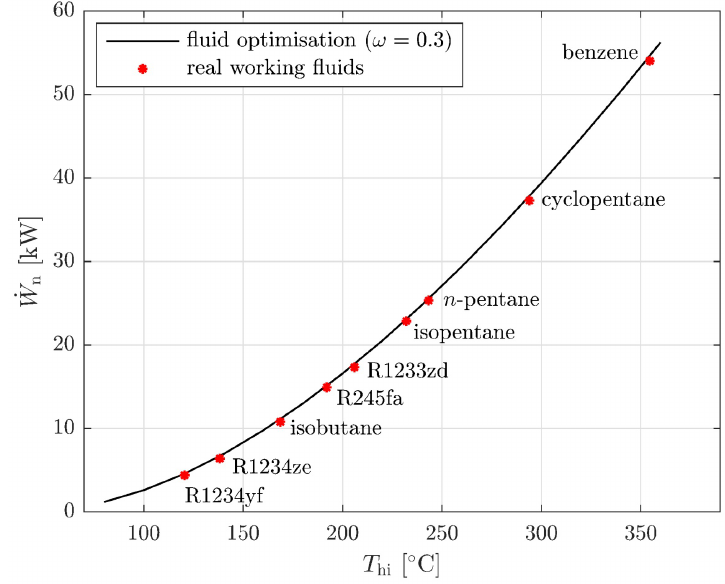
Figure 7. Working fluids comparison cycle optimizations with different working fluids operating in sub-critical ORC systems